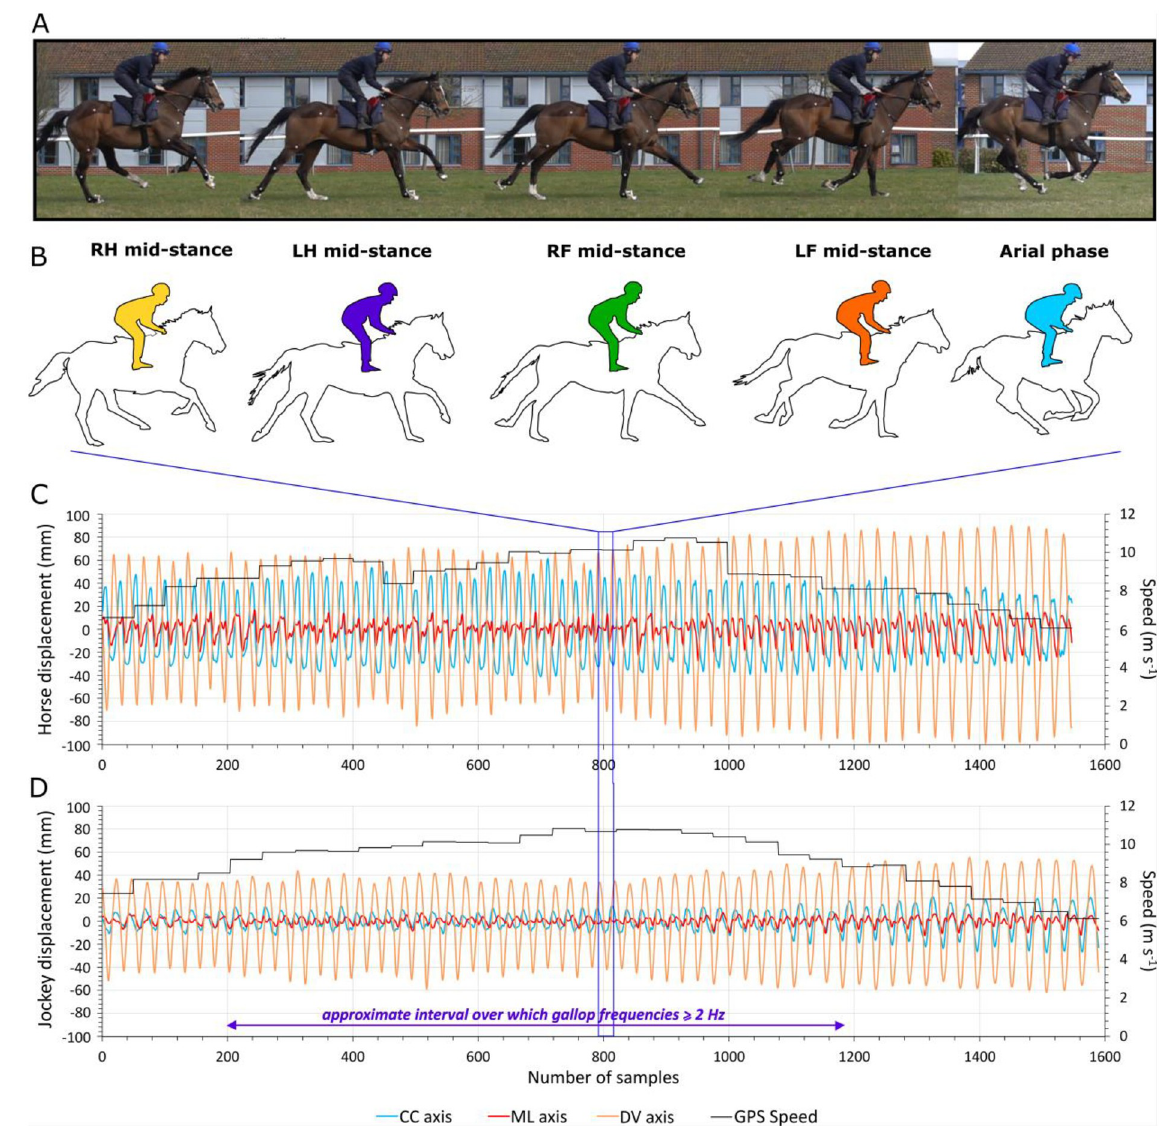
Fig 4. Overview of horse and jockey displacements. A . Photographs of horse and jockey over a gallop stride cycle illustrating changes in their body movements. B . Schematic diagrams highlighting the subtle variation in jockey position shown in A. C . Horse tri-axial displacements during a gallop interval. D . Jockey tri-axial displacements over the same gallop interval shown in C. Note that the alignment of speed data to acceleration data is only approximate.